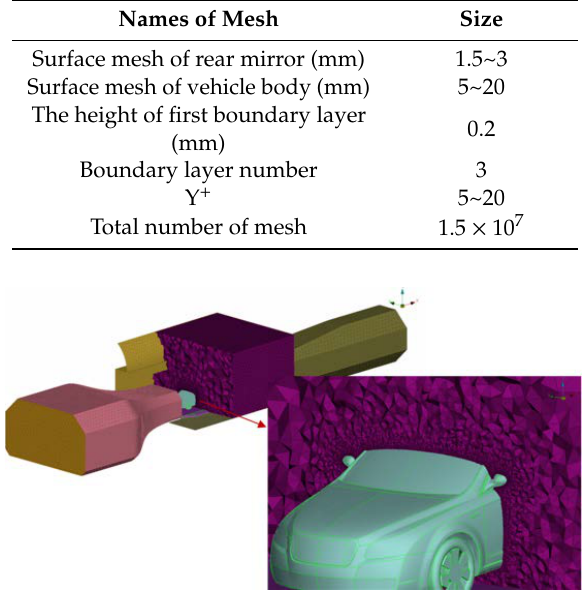
Figure 10. Volume grids.